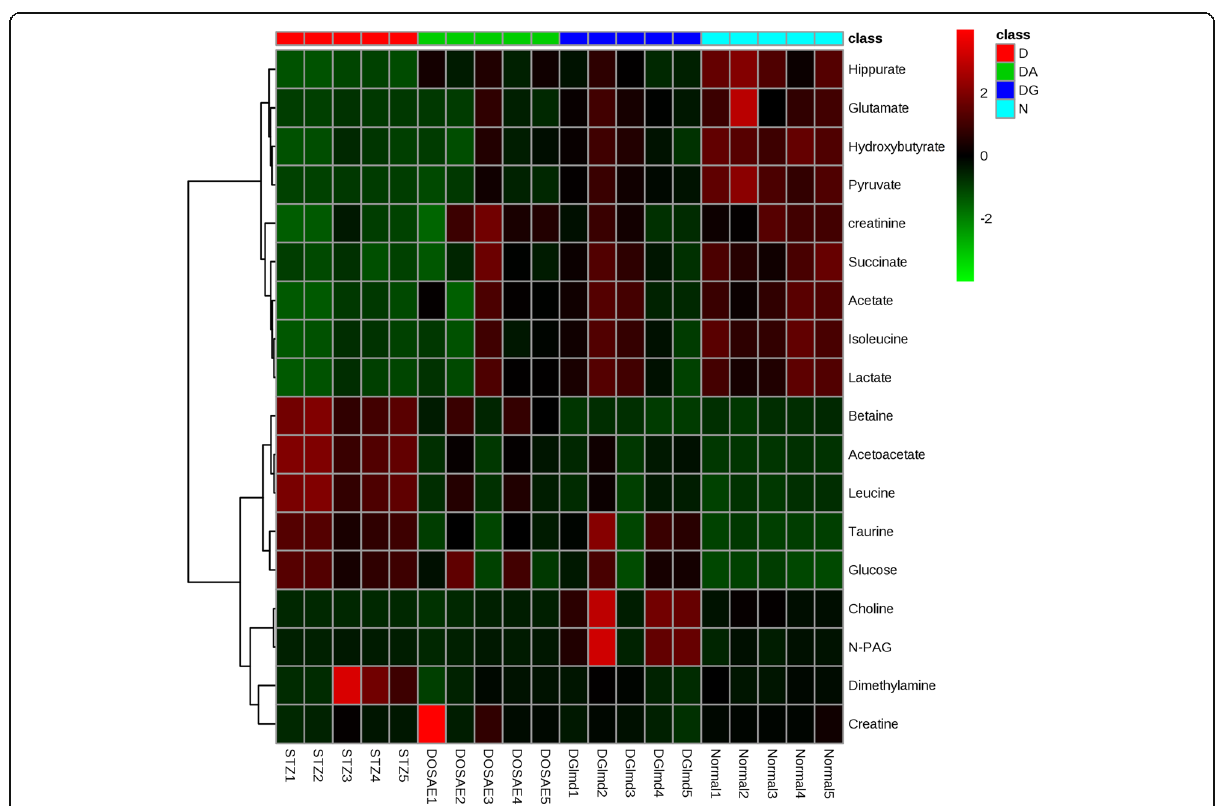
Fig. 5 Heat map of the identified biomarkers of Normal, diabetic, D-A and D-G rat urine based on HCA using Ward ’ s minimum variance method and Euclidean distance. The concentration of each metabolite is colored based on a normalized scale from minimum − 3 ( dark green ) to maximum 3 ( dark red